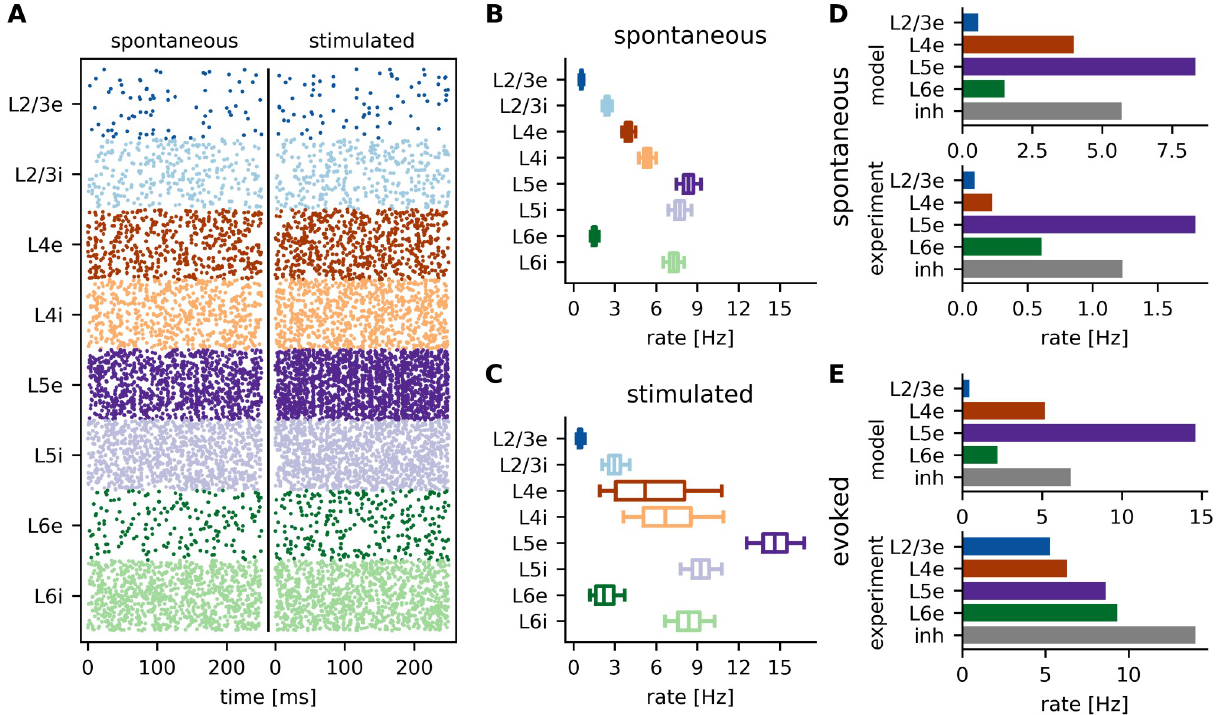
Fig 2. Spiking neuronal network. A 250ms raster plot for both spontaneous and stimulated conditions, depicting 500 neurons of each of the eight subpopulations. B-C Box plots of the firing rate distribution within each population, for spontaneous (B) and stimulated (C) conditions, respectively. Shown are the median (central line), lower and upper quartiles (box) as well as 5% and 95% percentiles (whisker bars). D-E Comparison of median spontaneous (D) and evoked (E) rates between model results and experimental values reported by [1]. Evoked rates are given by the maximal response over all angles. The experimental results were obtained by summing the spontaneous and evoked rates from [1] for direct comparison. For the model results, the inhibitory rates are averaged over all layers for better comparison with the data from experiments.